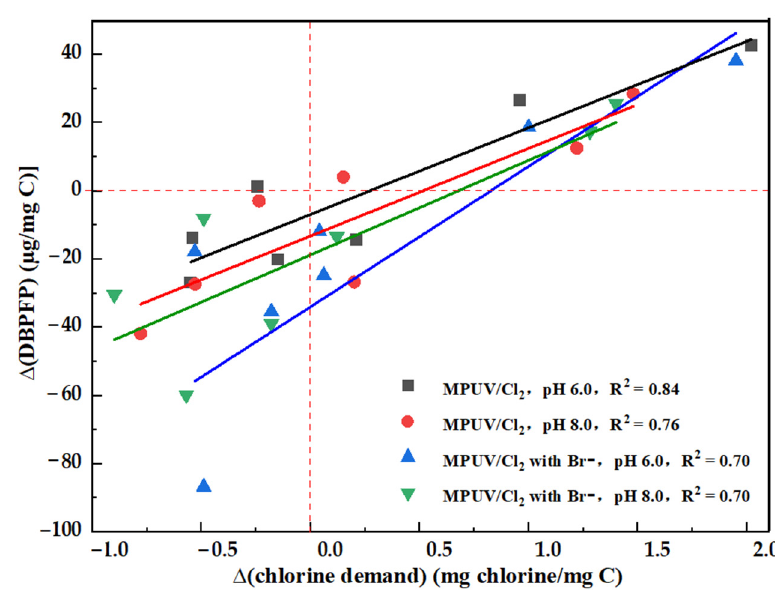
Figure 7. Linear fitting between ∆ (chlorine demand) and ∆ (DBPFP) caused by MPUV/chlorine AOP oxidation.